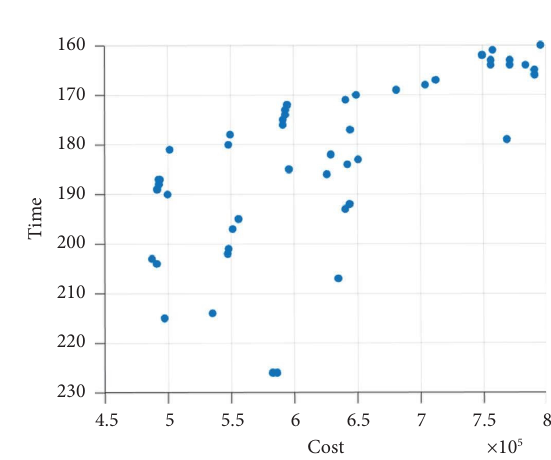
Figure 4: Time-cost trade-of.